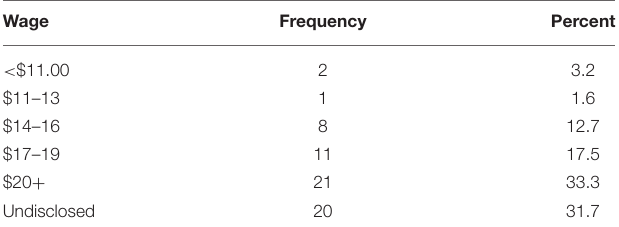
TABLE 3 | Hourly payment.